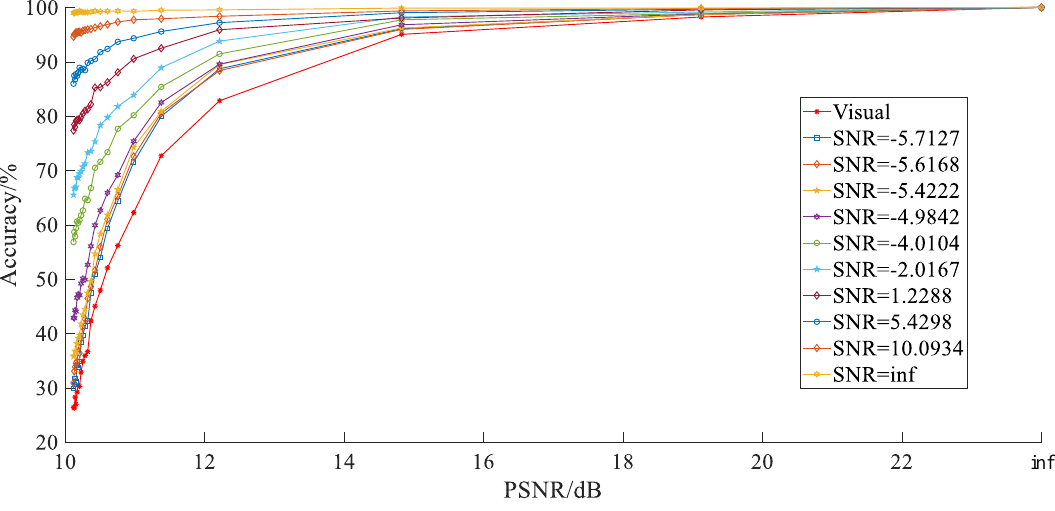
Figure 12. Recognition accuracies of Visual and FFS II-Acoustics-Visual of different SNR.